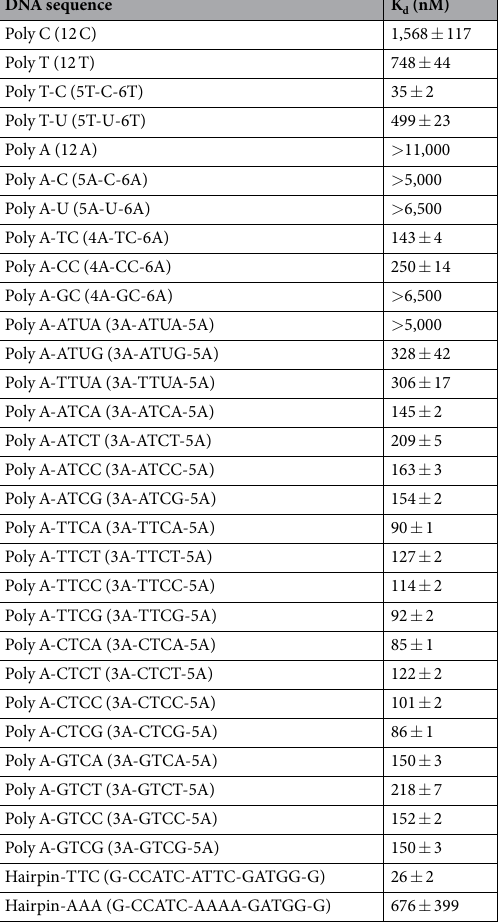
Table 1. A3A affinity for DNA sequences used in this